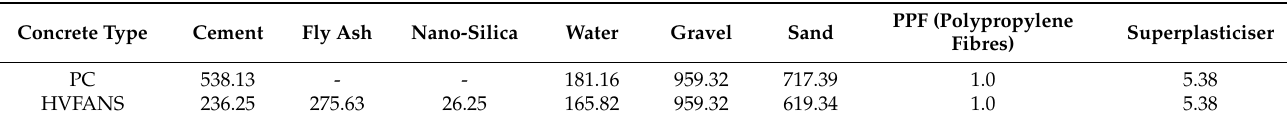
Table 2. PC (Plain Concrete) and HVFANS (high volume fly ash inclusion with nano-silica) concrete mixing proportions (kg/m 3 ).